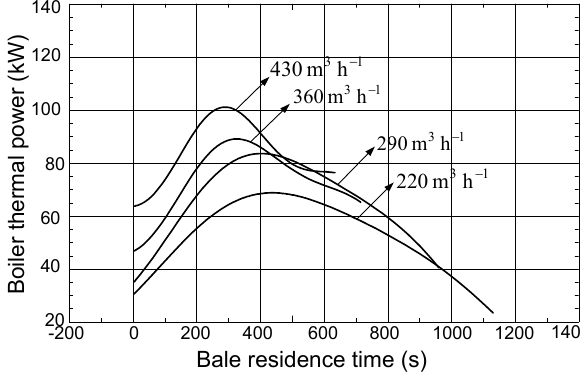
Figure 5. Correlation between boiler thermal power and bale residence time, model (1), recirculation